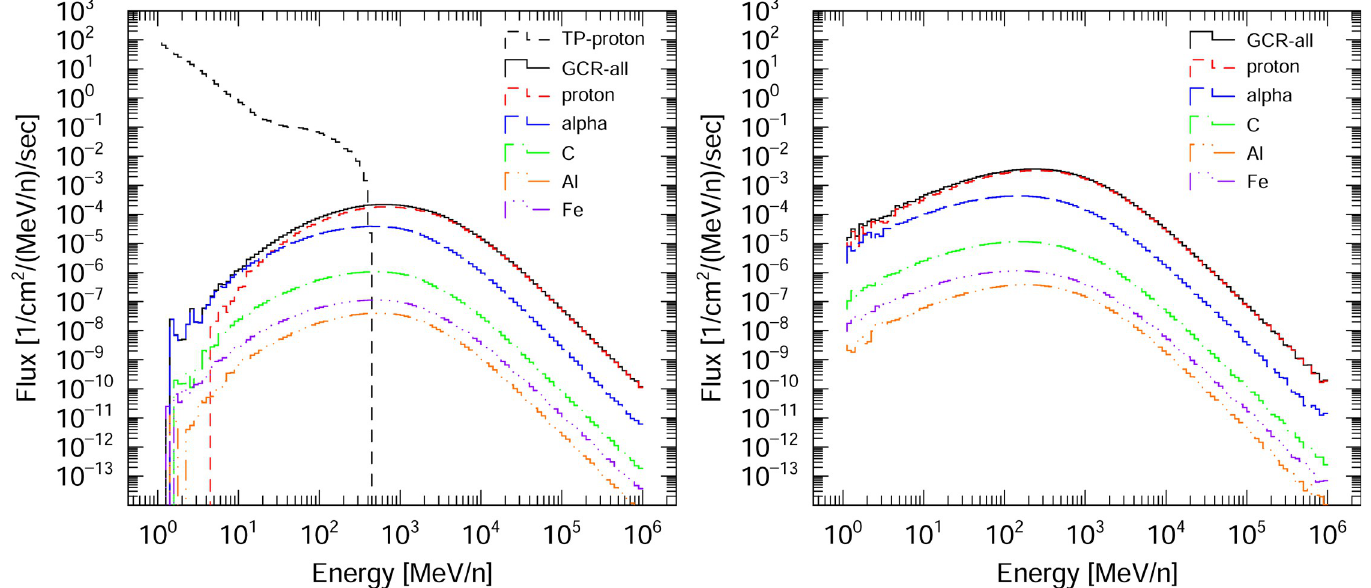
Fig 3. Particle energy spectra of radiation sources for a low-Earth orbit (left) and for deep space (right). The GCR and TP fluxes are included in low-Earth orbit and the GCR fluxes are included in deep space. Note that electrons in space-based radiation are ignored in the current version of PHITS.